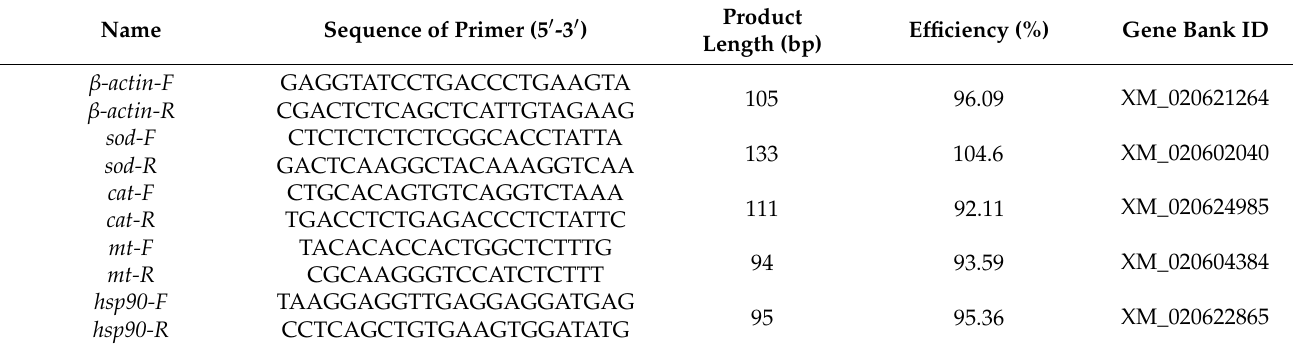
Table 1. Primer sequences for